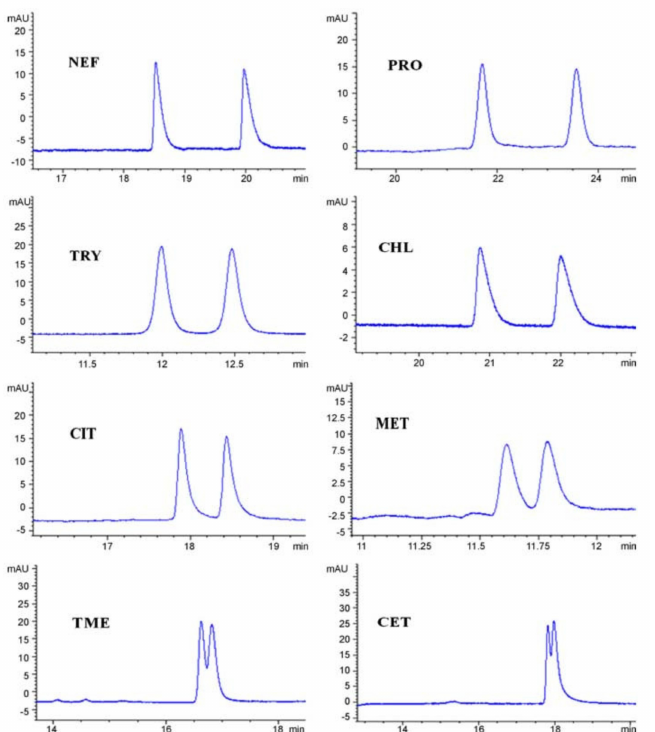
Figure 10. Enantio-separation of model basic drugs by MEKC using clindamycin phosphate as CS (Nefopam—NEF, PRO—propranolol, TRY—tryptophan, CHL—chlorphenamine, CIT—citalopram, MET—metoprolol, TME—tryptophan methyl ester, CET—cetirizine) (CS concentration 60 mM (NEF, PRO, CHL, TME, and CET) and 80 mM (TRY, CIT, MET). The figure is reproduced from Chen et al.